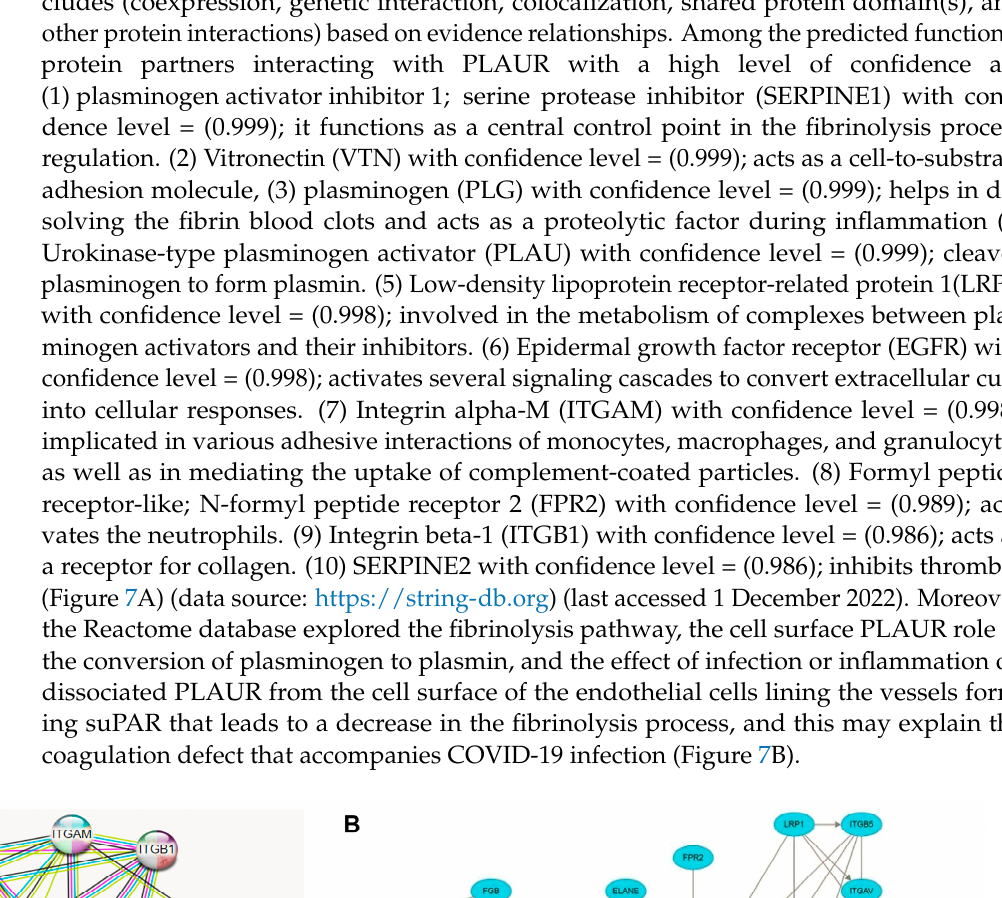
(Figure 7A) (data source: https://string-db.org) (last accessed 1 December 2022). Moreover, the Reactome database explored the fibrinolysis pathway, the cell surface PLAUR role in the conversion of plasminogen to plasmin, and the effect of infection or inflammation on dissociated PLAUR from the cell surface of the endothelial cells lining the vessels form- ing suPAR that leads to a decrease in the fibrinolysis process, and this may explain the coagulation defect that accompanies COVID-19 infection (Figure 7B).